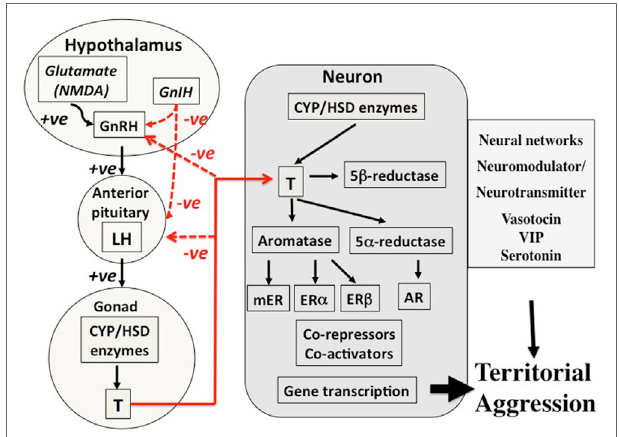
FigUre 2 | Control mechanisms for territorial aggression in birds in spring. There are three major components to control mechanisms. First, the regulation of hormone secretion from the hypothalamo–pituitary–gonad axis (left part of the figure), transport of hormones such as testosterone in the blood (lines in red), and the mechanisms associated with action of the hormone in the target cell, in this case a neuron in the brain (central part of the figure). The net result is regulation of territorial aggression by neural networks (right-hand part of the figure). This three-part system of control of hormone secretion, transport, and effects on target organs is an important concept because it offers many points of potential regulation. The secretion component on the left summarizes how sensory information, in this case social, in transduced through neurotransmitter, e.g., glutamate (NMDA), and neuroendocrine secretions such as gonadotropin- releasing hormone (GnRH) and gonadotropin-inhibiting hormone (GnIH) into release of gonadotropins luteinizing hormone (LH) and follicle-stimulating hormone (not shown) from the anterior pituitary into the blood. LH travels to the gonad where it acts on cells that express steroidogenic enzymes to stimulate secretion of the sex steroid hormone testosterone (T) that is in turn released into the blood. Local actions of T in the testis include regulation of spermatogenesis, but it is also released into the blood in many avian species during breeding. Among many actions of T are effects on territorial aggression, and negative feedback on neuroendocrine and pituitary secretions (red lines). In birds, T circulates bound weakly to corticosteroid-binding globulin before entering target neurons involved in the expression of territorial aggression (center of figure). Once T has entered a target neuron, it has four potential fates. First, it can bind directly to the androgen receptor (AR), a member of the type 1 genomic receptors that become gene transcription factors once they are bound to T. Second, T can be converted to estradiol (E2) by the enzyme aromatase. E2 can then bind to either estrogen receptor alpha (ER α ) or estrogen receptor beta (ER β ) both of which are genomic receptors that regulate gene transcription, but different genes from those regulated by AR. Third, T